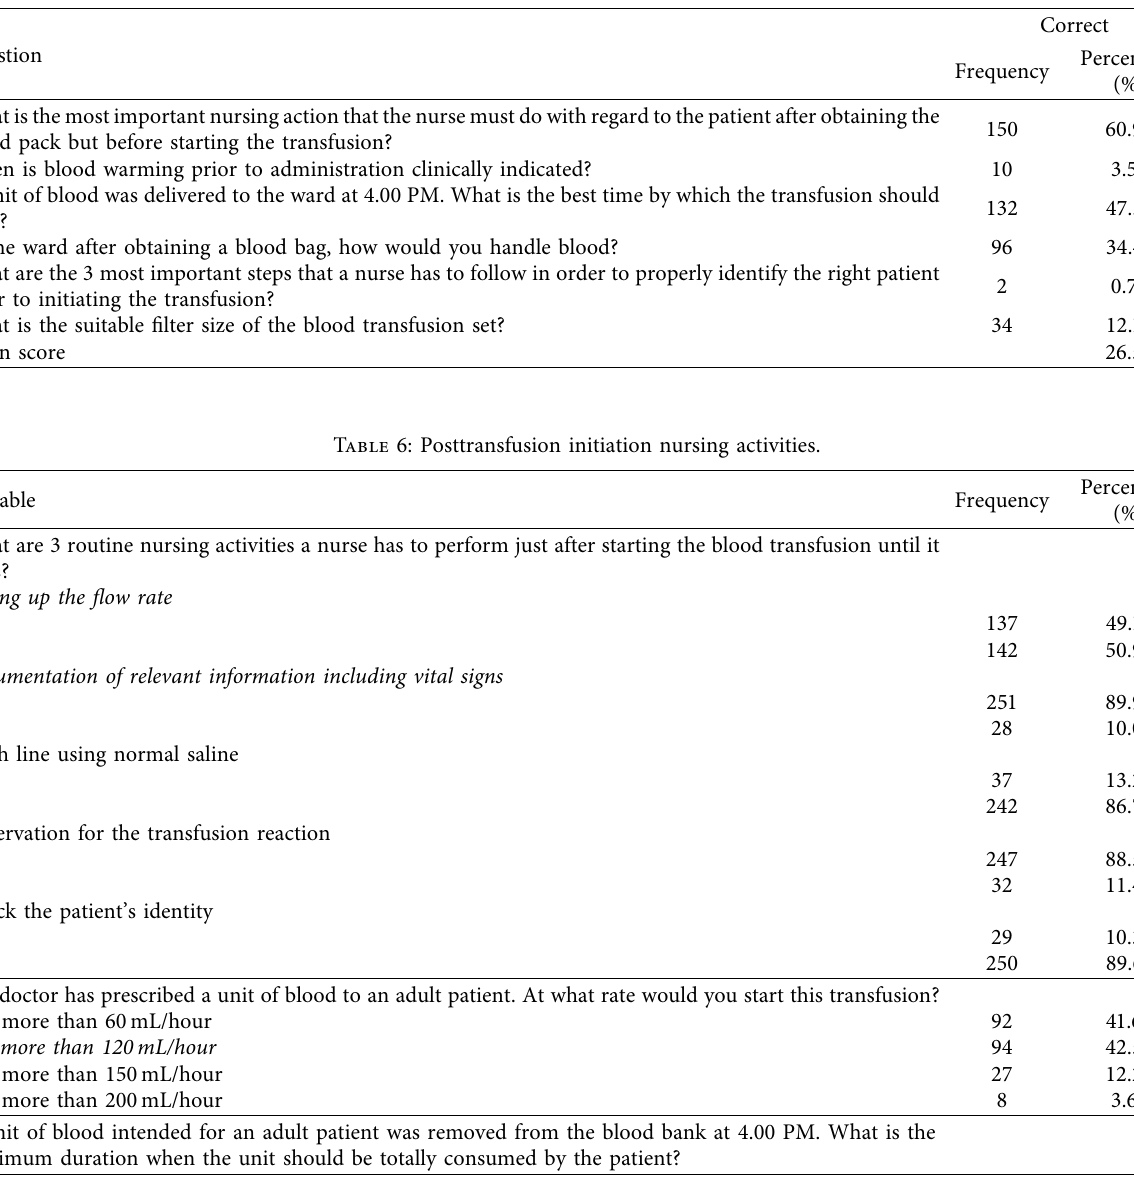
Table 5: Nurses’ knowledge of pretransfusion nursing activities.